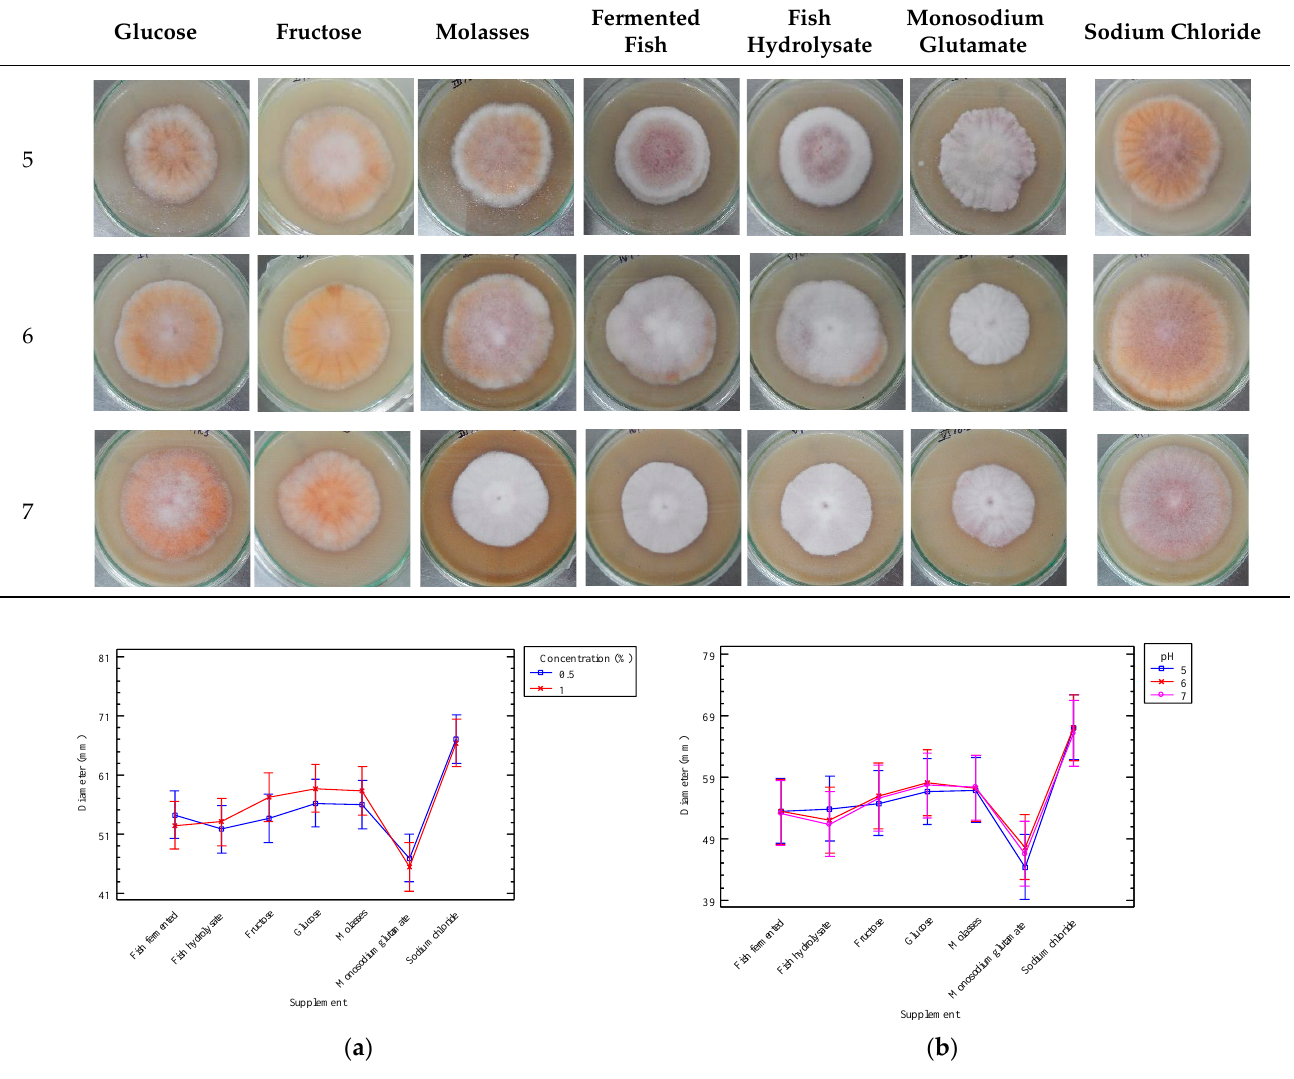
Figure 1. The figure shows ( a ) the interactions of supplement and substrate concentration in percentages; and ( b ) the interaction of supplement and pH on the radial growth of the fungus in vitro.